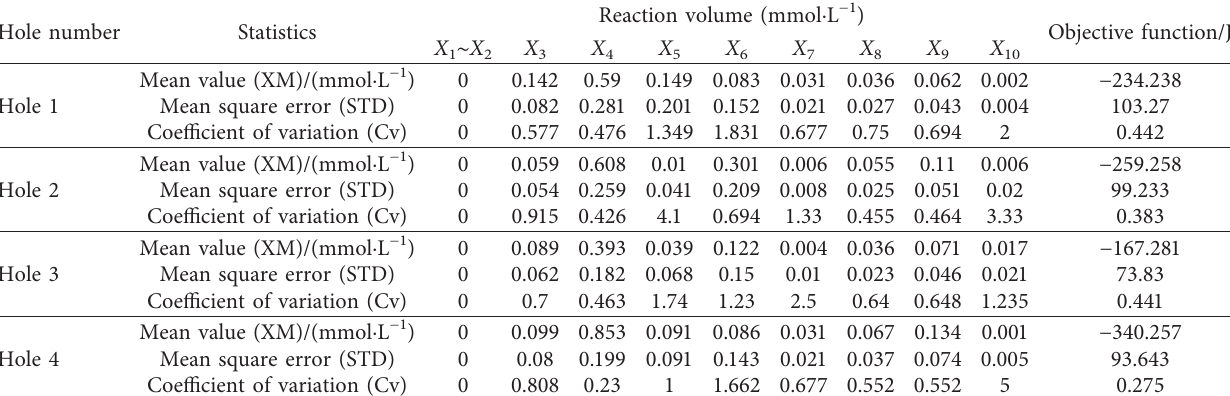
Table 3: Random simulation results of the state of the water-rock interaction